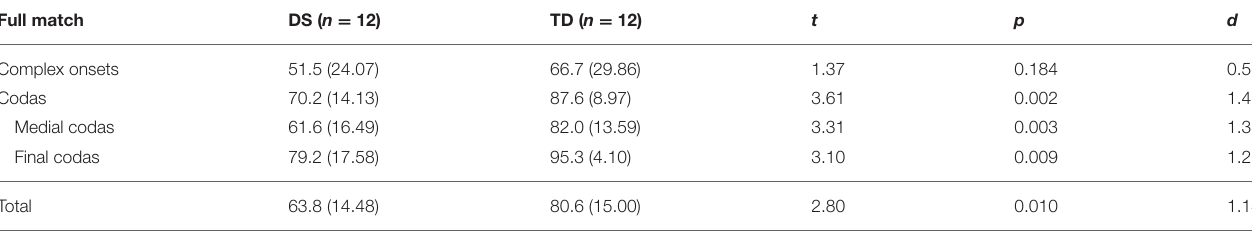
TABLE 3 | Full match percentage in complex onset and coda positions, t -test values and Cohen’s d effect sizes. Full